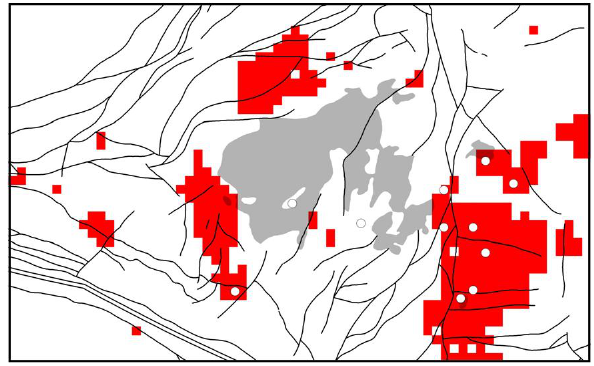
Fig. 7 Regional geochemical anomalies extracted by applying S-A fractal filtering to the scores calculated from the first principal component derived from Fig. 8 Posterior probability map created by means of weights of evidence Fig. 7. Regional geochemical anomalies extracted by applying S-A Fig. 8. Posterior probability map created by means of weights of logarithmic transformed concentration values of elements Sn, As, Cu, Pb, Zn and method applied to the four evidential layers in Figs. 4 to 7. Cd. The patterns in red are the binary patterns created from the decomposed filtering to the scores calculated from the first principal component evidence method applied to the four evidential layers in Figs. 4 to patterns by means of S-A method. Details can be found in Cheng et al. (2009). fractal derived from logarithmic transformed concentration values 7. of elements Sn, As, Cu, Pb, Zn and Cd. The patterns in red are the binary patterns created from the decomposed patterns by means of S-A method. Details can be found in Cheng et al. (2009). for occurrences of mineral deposits. Using model (12), four layers of binary maps were combined; the posterior proba- bility map that emerged is shown in Fig. 8. The areas with high posterior probability values contain most of the known mineral deposits; some areas with high posterior probabili- ties in which mineral deposits have not yet been found can be considered target areas for further